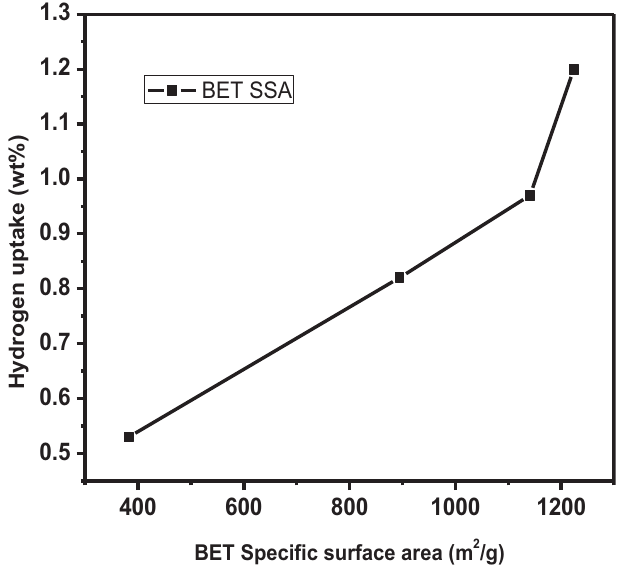
Fig. 7. Relationship between stored maximum H 2 content (wt. %) and BET speci fi c surface area (m 2 /g) in activated carbon at 30 ° C and 40